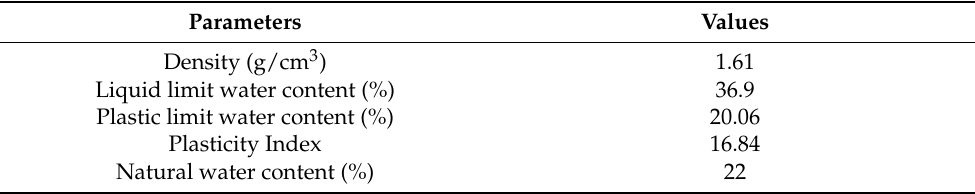
Figure 3. Particle size distribution curve. Table 1. Physical properties of the undisturbed soil.